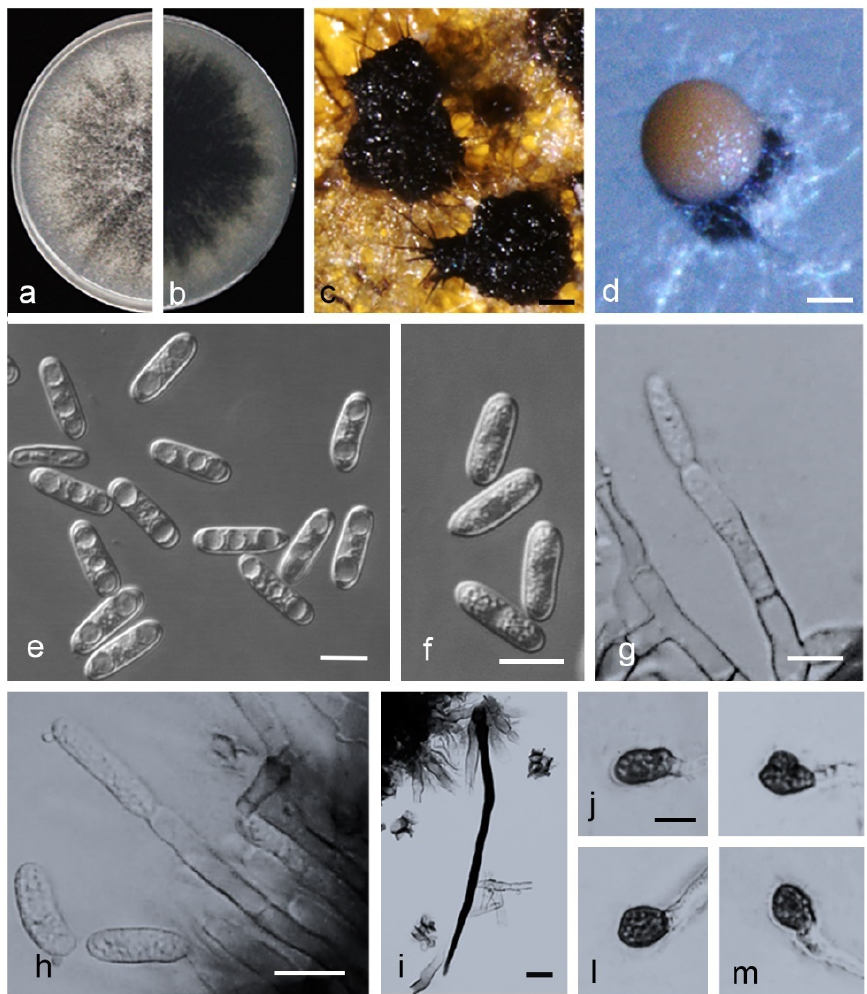
Figure 15. Colletotrichum qilinense . ( a , b ) Front and back view, respectively, of 9-d-old PDA culture; ( c , d ) conidiomata; ( e , f ) conidia; ( g , h ) conidiophores; ( i ) seta; ( j – m ) appressoria; ( a – e , h – m ) isolate CAASZK13; ( f , g ) isolate CAASZZ7; ( a – c ) produced on PDA agar medium; ( d – m ) produced on OA agar medium). Scale bars: ( c , d ) = 100 µ m; ( i ) = 20 µ m; ( e – h , i – m ) = 10 µ m; j applies to ( j – m